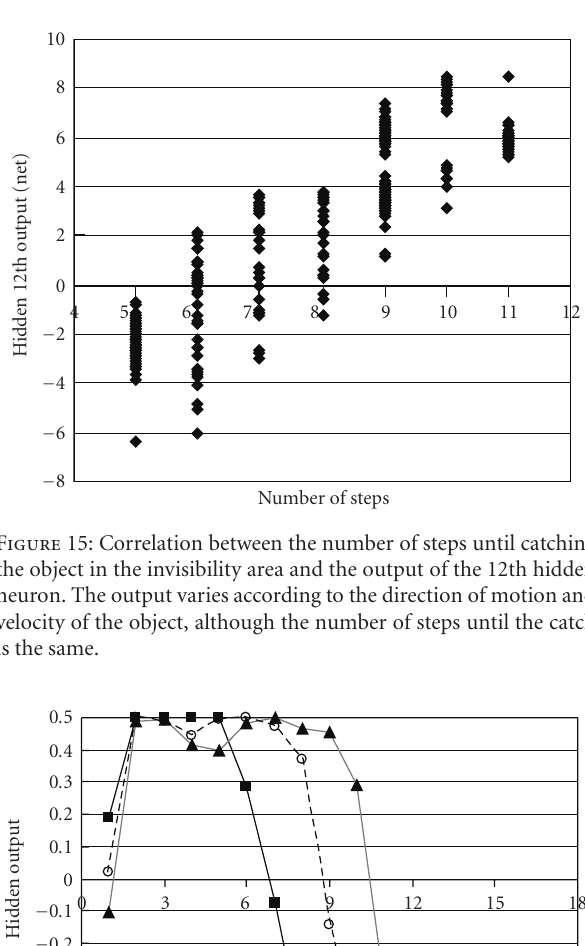
Figure 14: Connection weights to the 12th neuron from the input neurons responsible for the x location of the object. Lateral axis indicates the most responsible point of each input neuron.